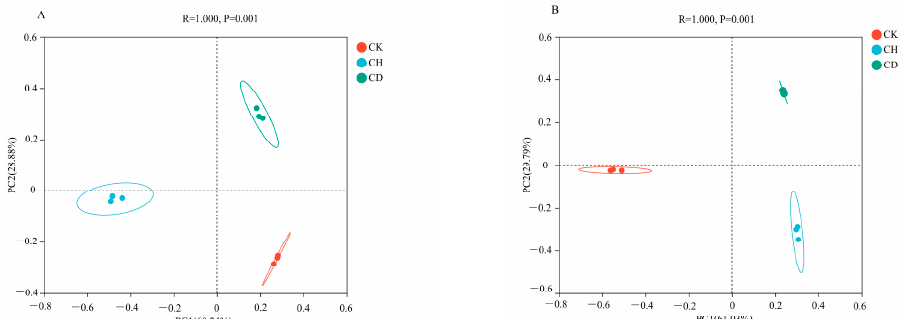
Figure 8. ( A ) PCoA analysis of bacterial community structure. ( B ) PCoA analysis of fungal